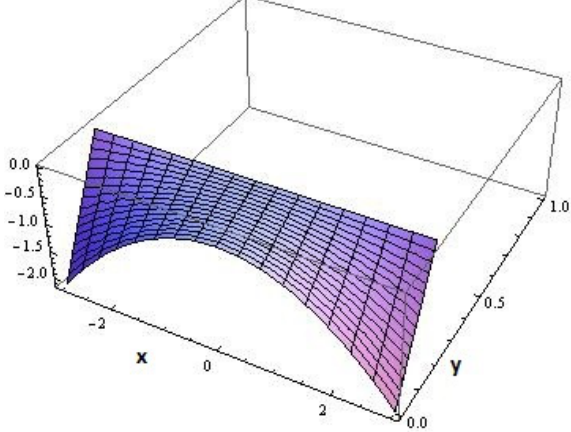
Figure 3. The flow component F T of the free energy as a function of the vacuum parameter x : = θ and temperature y : = T , describing fluctuations of the YM vacuum ensemble for a given anomaly factor c , decoherence temperature d , and critical exponent e